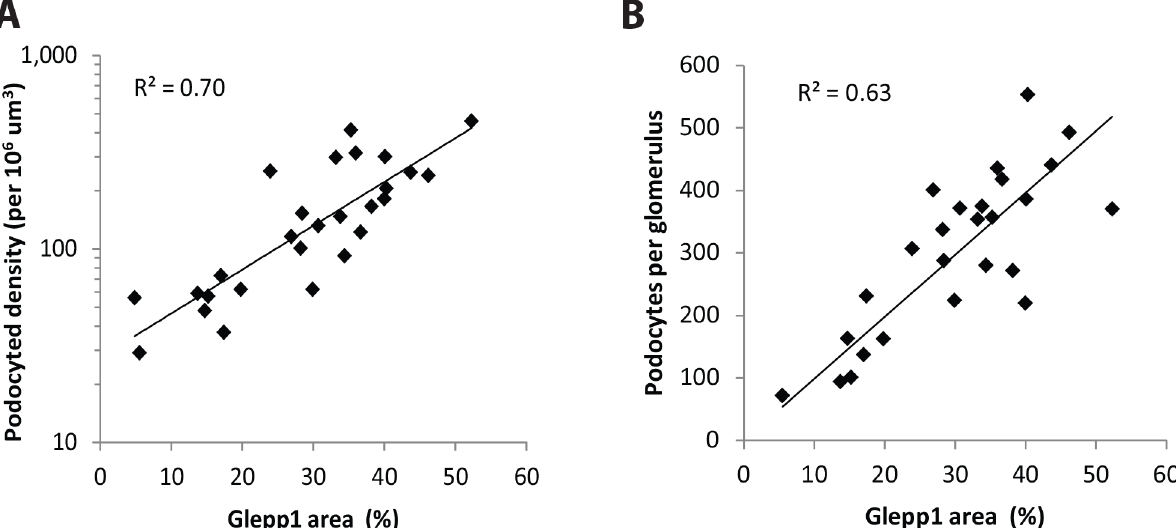
Fig 2. Comparison of two methods for measuring podocyte density. Panel A . Log podocyte density plotted versus Glepp1 area (%). The two methods correlate with R 2 = 0.70. Panel B . Podocyte density x glomerular volume gives the podocyte number per tuft. This value also correlates well with Glepp1 area (R 2 = 0.63). Bland-Altman comparison of podocyte density and podocyte number per glomerulus shows a mean difference of 106 (95% confidence interval of 115 to 327), and the Pitman ’ s test of difference in variance reveals r = 0.072, p = 0.728 indicating comparable results.